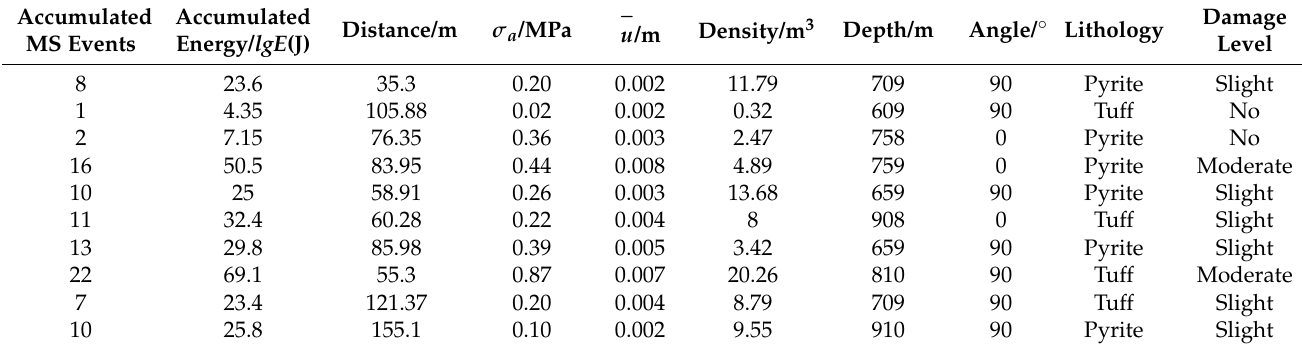
Table 3. Example of observation data that includes the evaluation indexes and the damage level.